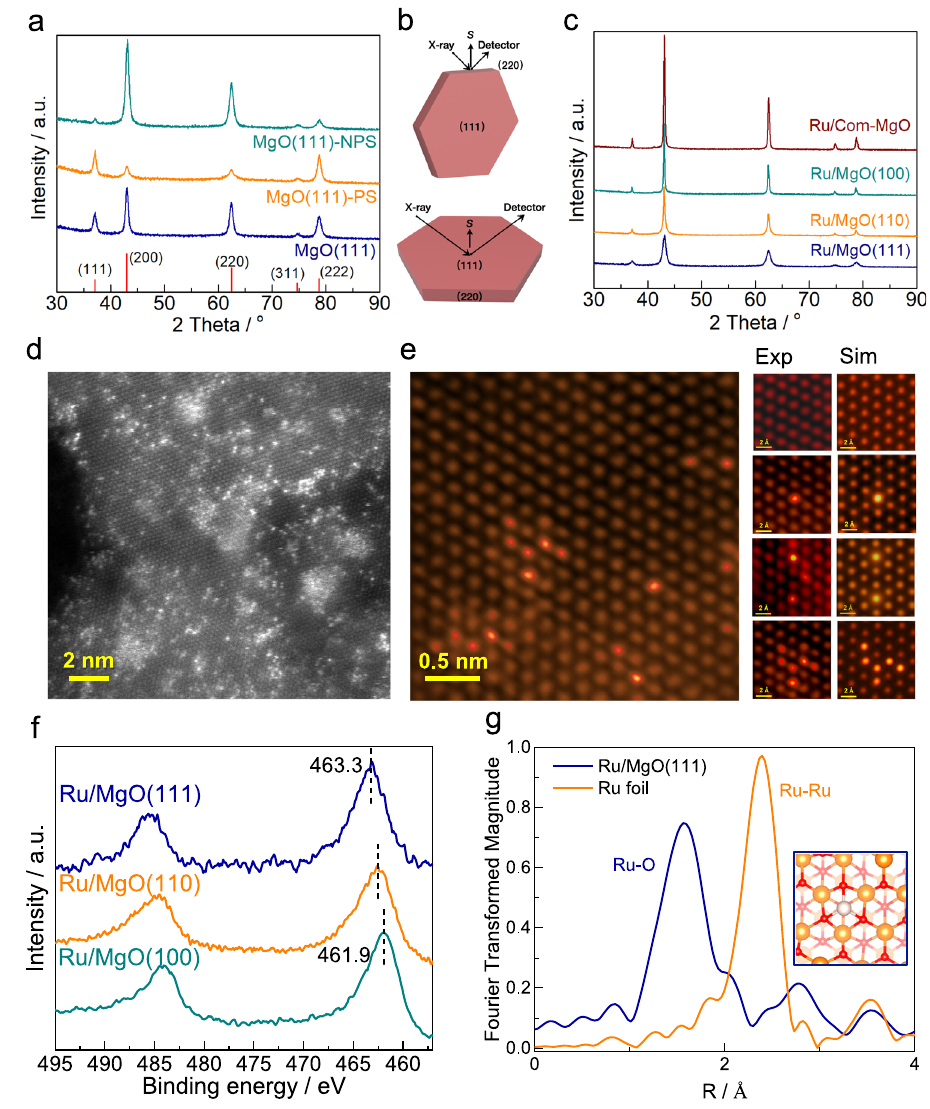
Fig. 1 | Characterizations of Ru/MgO(111), Ru/MgO(110) and Ru/MgO(100). a XRDpatternsofMgO(111)samplespreparedindifferentsolvents.Note:MgO(111)- PS and MgO(111)-NPS are assembled in ethanol and n-hexane as the polar solvent (PS) and non-polar solvent (NPS), respectively; b illustration of XRD patterns from ideally aligned MgO(111) nanosheets perpendicular and parallel to the diffraction vector s; c XRD patterns of 3.1 wt.% Ru supported on MgO with different pre- dominantexposedfacets; d HAADF-STEMimagesof3.1wt.%Ru/MgO(111),thescale bar in yellow is 2 nm; e HAADF-STEM images with observed single Ru atoms in the